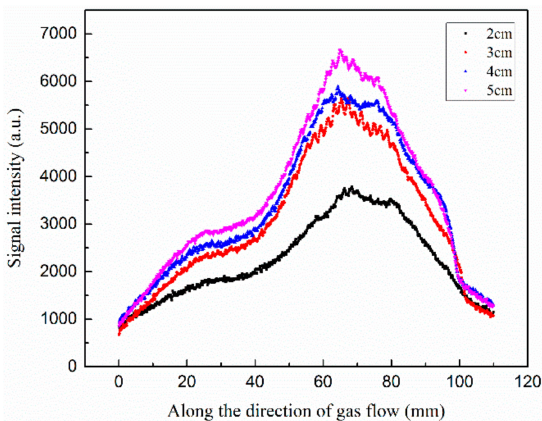
Figure 11. The distribution of OH signal from different laser sheet